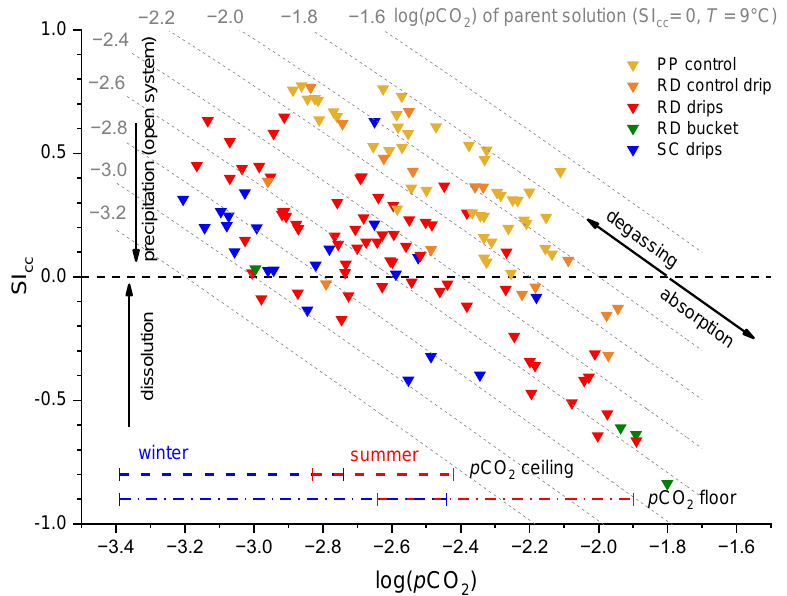
Figure 14. Dripwater SI cc in Pisani Passage as a function of log( p CO 2 ). The grey lines denote the processes of CO 2 absorption or degassing from a parent solution (assuming SI cc = 0, T = 9 °C) and range from log( p CO 2 ) = −3.2 (~630 ppm) to log( p CO 2 ) = −1.6 (~25,000 ppm). The measured ranges of the cave air p CO 2 are marked by dashed lines for the winter (blue) and summer (red) for the ceiling and floor CO 2 probes. Note that, at a cave air p CO 2 of 10 −2.2 (6300 ppm), the RD drips associated with the corrosion cups fall exclusively in the undersaturated area. The lowest value of SI cc is reached by the RD bucket.